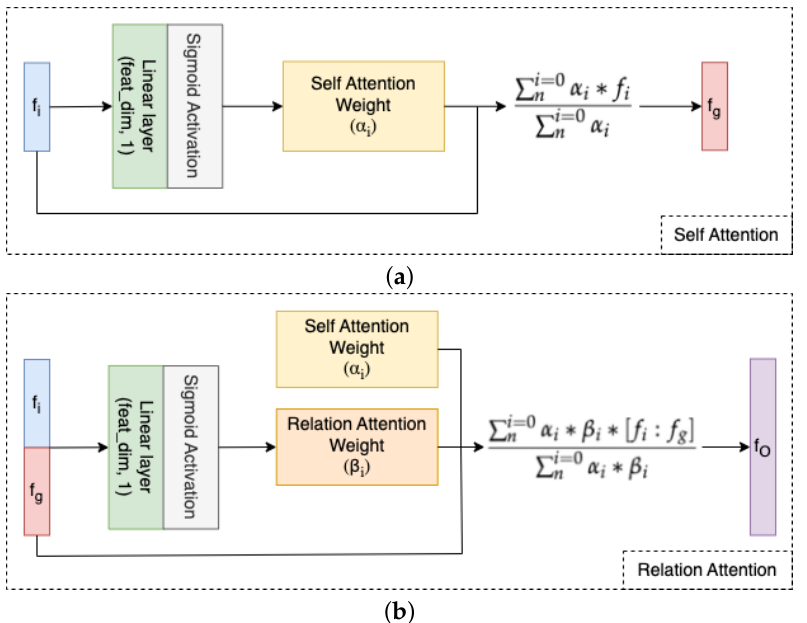
Figure 3. Self-Relation Attention (SRA) Module. This module has 2 attention sub-parts including Self Attention and Relation Attention. ( a ) Self Attention (SA) sub-module and ( b ) Relation Attention (RA) sub-module.